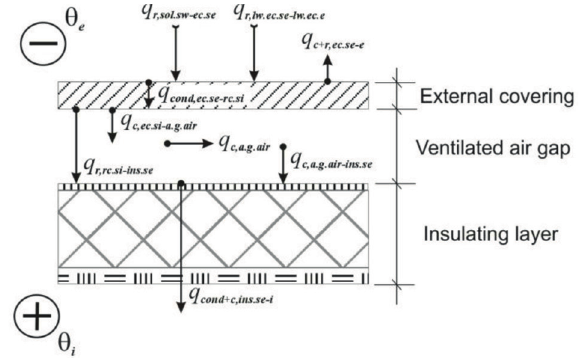
Fig. 2. Principal scheme of the ventilated envelope and indicators influencing its heat exchange eqns (1)–(4) system in the distance l l ≤ 0.5· l ) from the entrance of air into the x a.g.